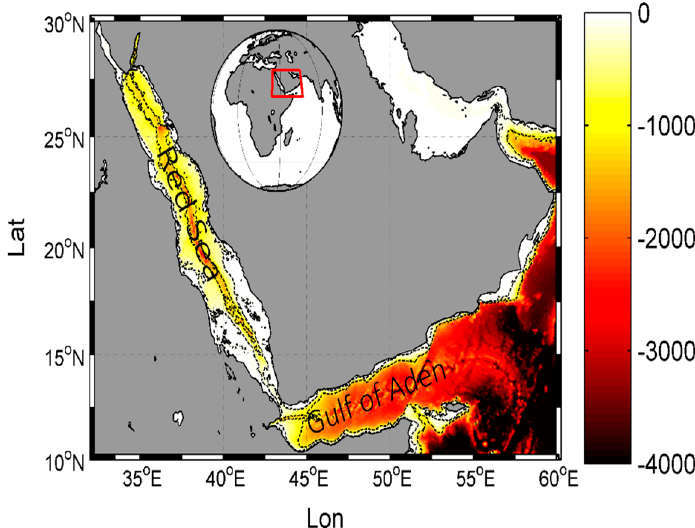
Figure 1. Map of the Red Sea (RS) and Gulf of Aden (GA) basins and the associated bathymetry in meters (m).